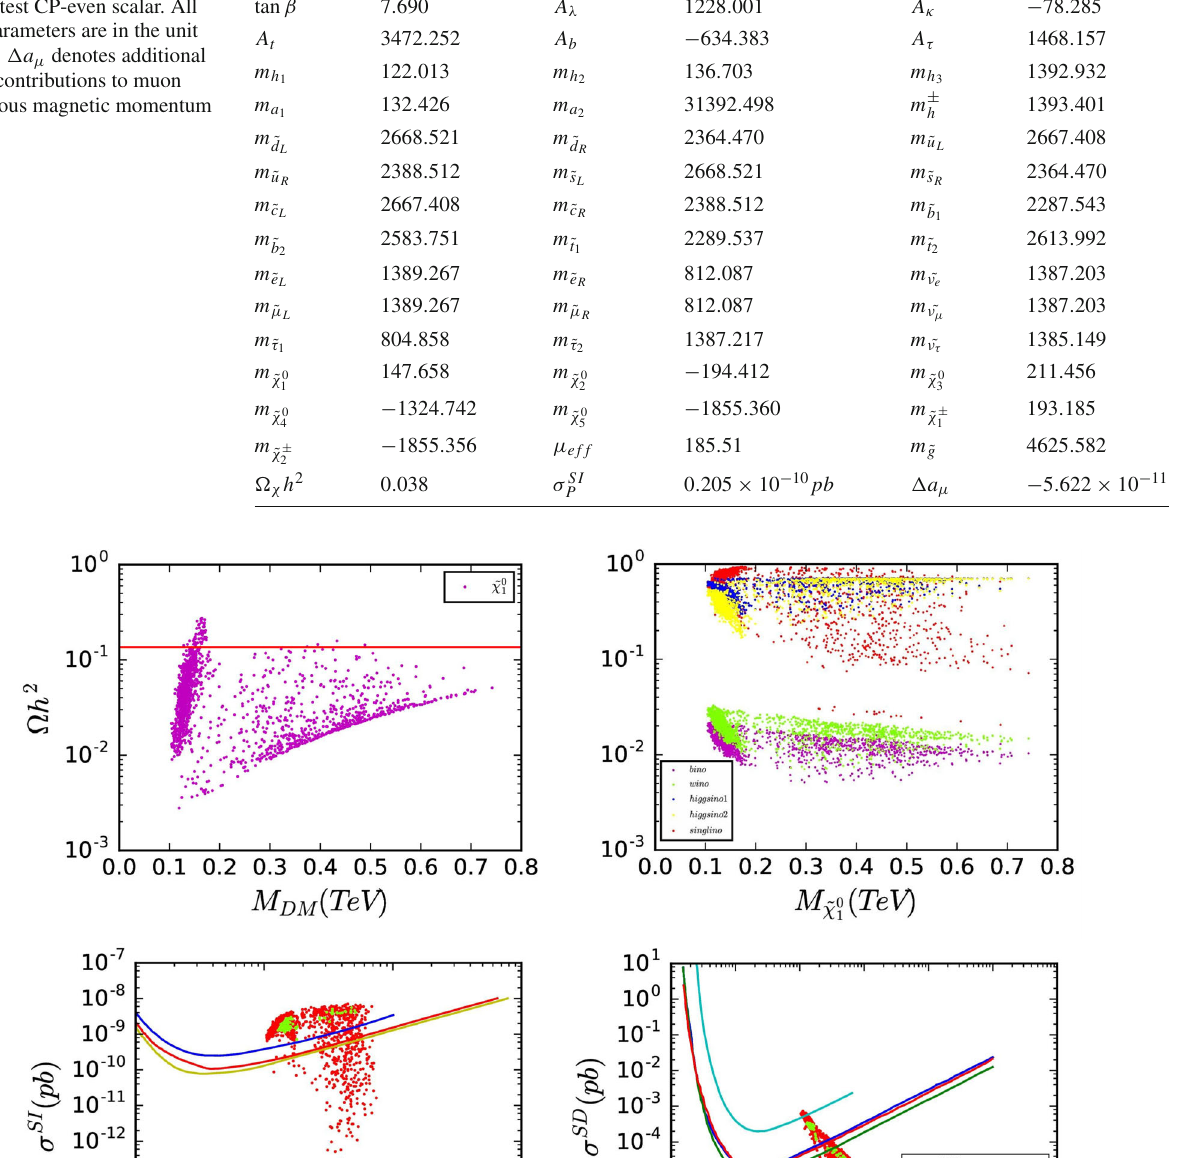
direct detection experiments are given in the lower panels, respectively. The green points denote the parameters that can provide full DM relic